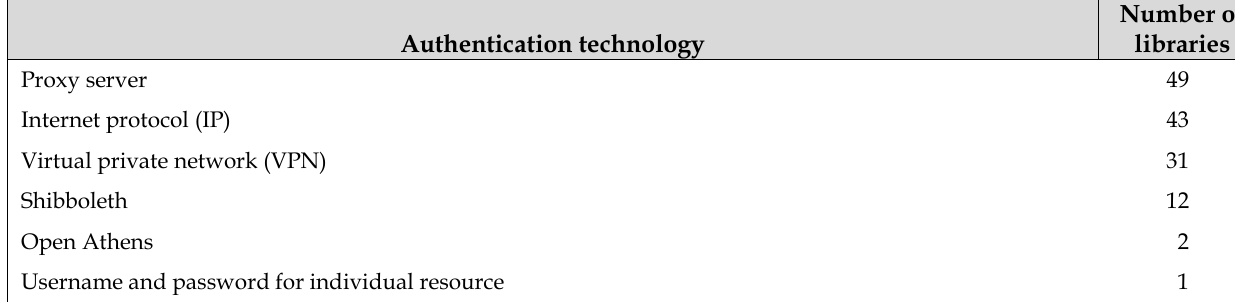
Table 2 Authentication technologies used by libraries